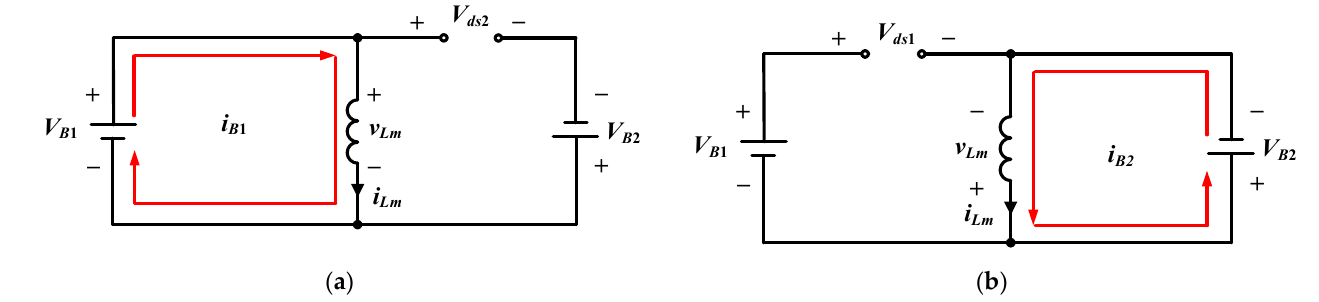
Figure 3. The energy transfer path from V B 1 to battery V B 2 : ( a ) battery V B 1 stores energy to the inductor and ( b ) the inductor releases energy to battery V B 2 .